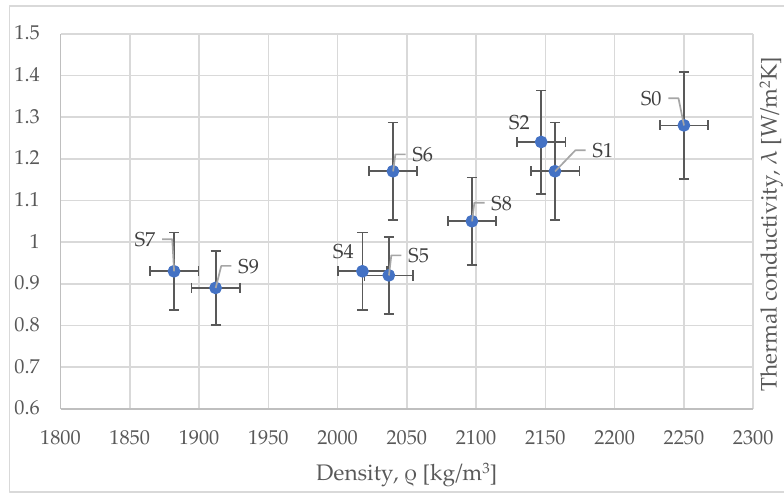
Figure 11. Variation of thermal conductivity versus density .